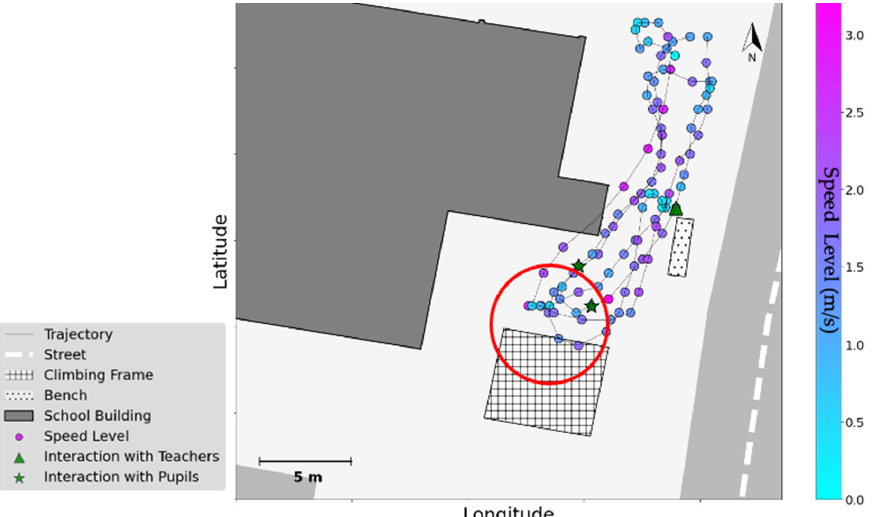
Figure 7. Cyclist in school A: the trajectory of movement is extracted from GPS data, and colour coded based on speed level (from light blue to light pink, following the colour bar). Face-to-face contacts are analysed from proximity tags, fused with GPS data, and mapped to the school floor plan (triangle: contacts with the teacher, and star: contacts with peers).